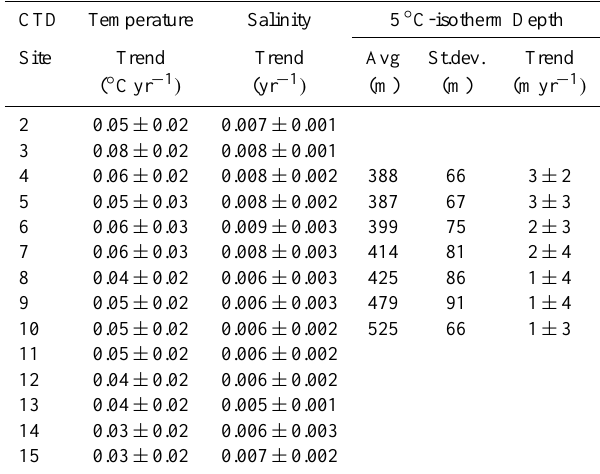
Table 2. Statistics and long-term trends of temperature, salinity, and the 5 ◦ C isotherm at the various CTD stations. The first columns show the trend and its 95% confidence interval of the temperature and salinity in the 50–100m depth interval. The last columns show the average (Avg), the standard deviation (St.dev.), and the trend of the depth of the 5 ◦ C isotherm for each standard station of sufficient depth. The trends are determined as the regression coefficient ± its 95% confidence interval, based on a linear regression analysis of the seasonal residuals on time. CTD Temperature Salinity 5 ◦ C-isotherm Depth